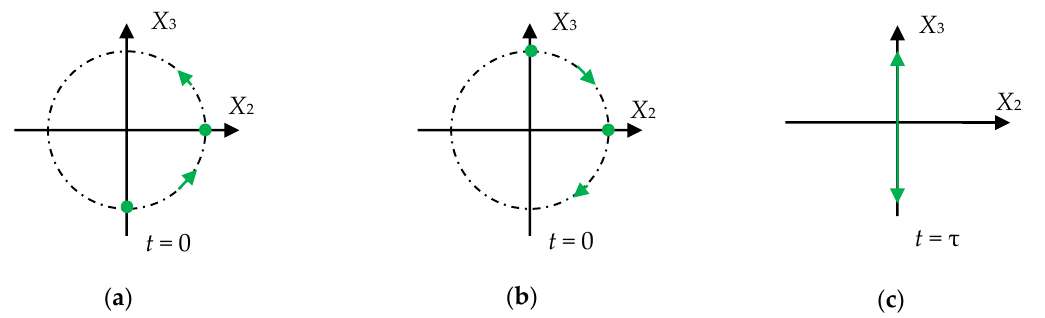
Figure 1. Particle movement pattern: ( a , b ) Basic circular polarized waves with counterclockwise, and clockwise directions of particle displacement, respectively; ( c ) total linearly polarized wave.